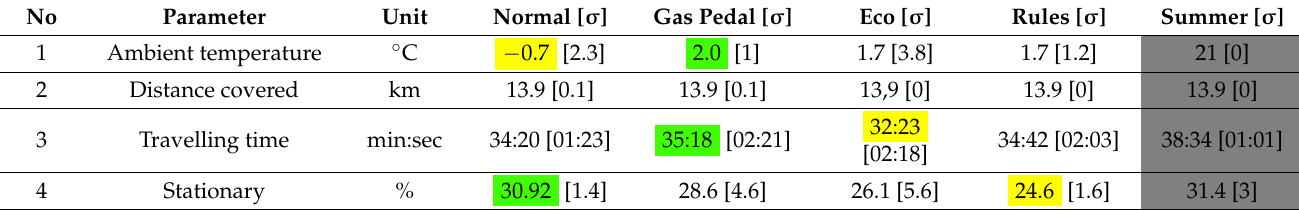
Table 3. Average test results. Green and yellow are used to mark maximum and minimum values, respectively. No